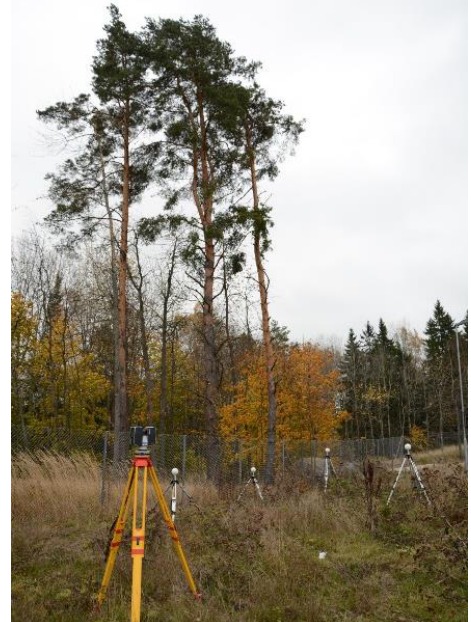
Figure 2. A separation of two images taken a minute apart under 9 m/s wind conditions, showing the increase in deformation towards top of the tree